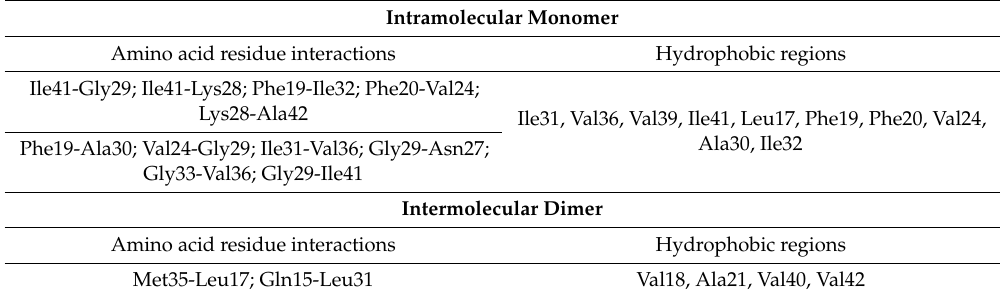
Table 2. Important intra- and intermolecular interactions during A β 1-42 aggregation in the